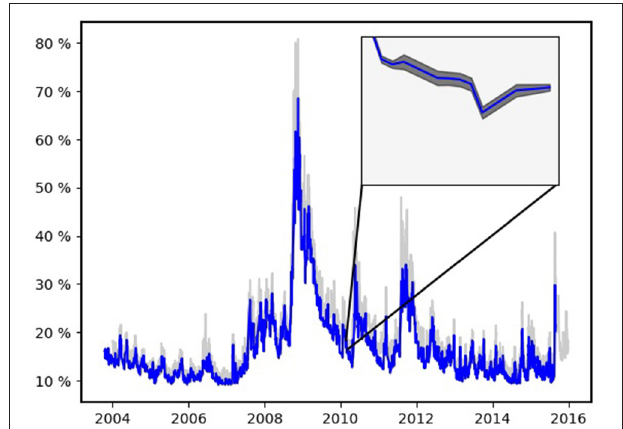
FIGURE 10 | The time series ( K var, t ) t with its 95% confidence region. The gray transparent line shows the historical VIX.